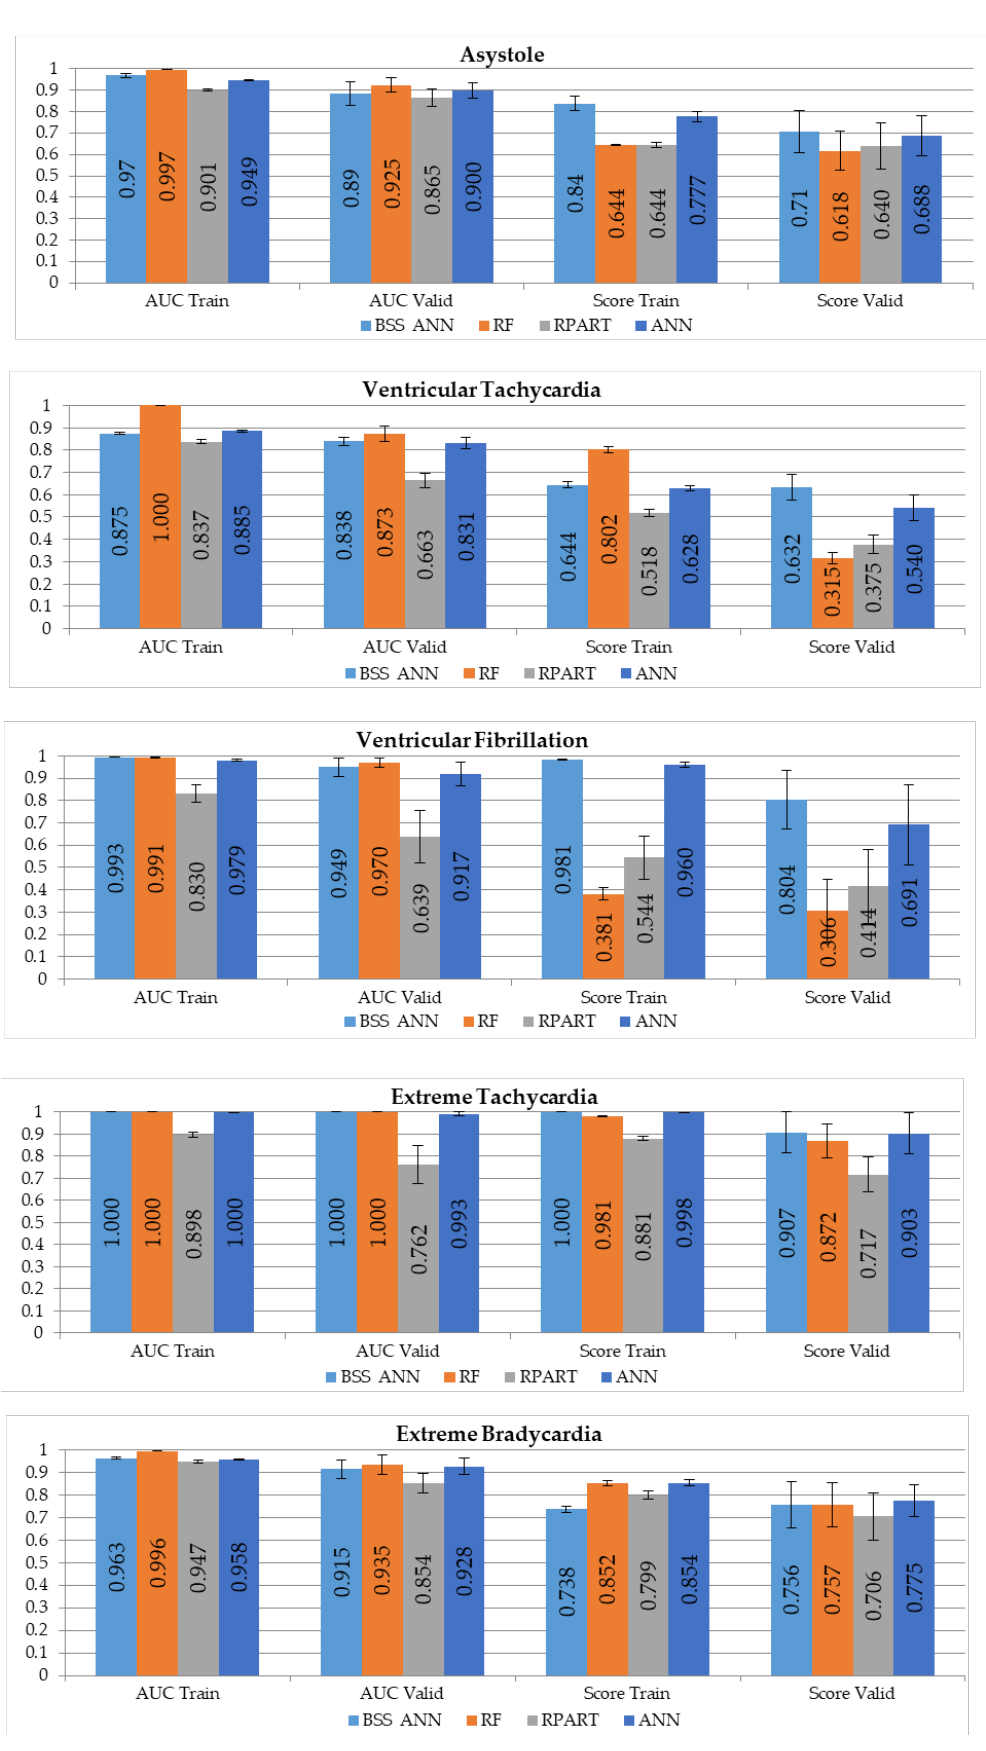
Figure 4. AUC and score results for each type of arrhythmia.